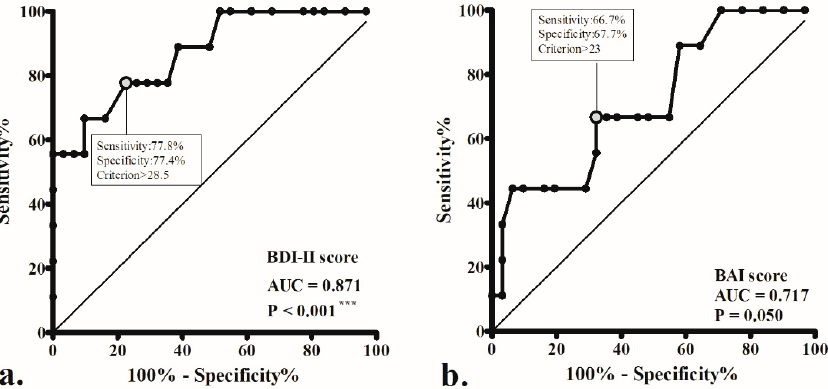
Figure 3. Receiver operating characteristic (ROC) curves to detect empty nose syndrome patients with residual psychological symptoms after surgery (postoperative Beck Depression Inventory II (BDI)-II scores of ≥ 15 and/or Beck Anxiety Inventory (BAI) scores of ≥ 14), using the variables of the preoperative BDI-II ( a ) and BAI scores ( b ). The optimal cut-offs for these metrics (maximizing the sum of sensitivity and specificity) are indicated. AUC: area under the ROC curve; *** p < 0.001.